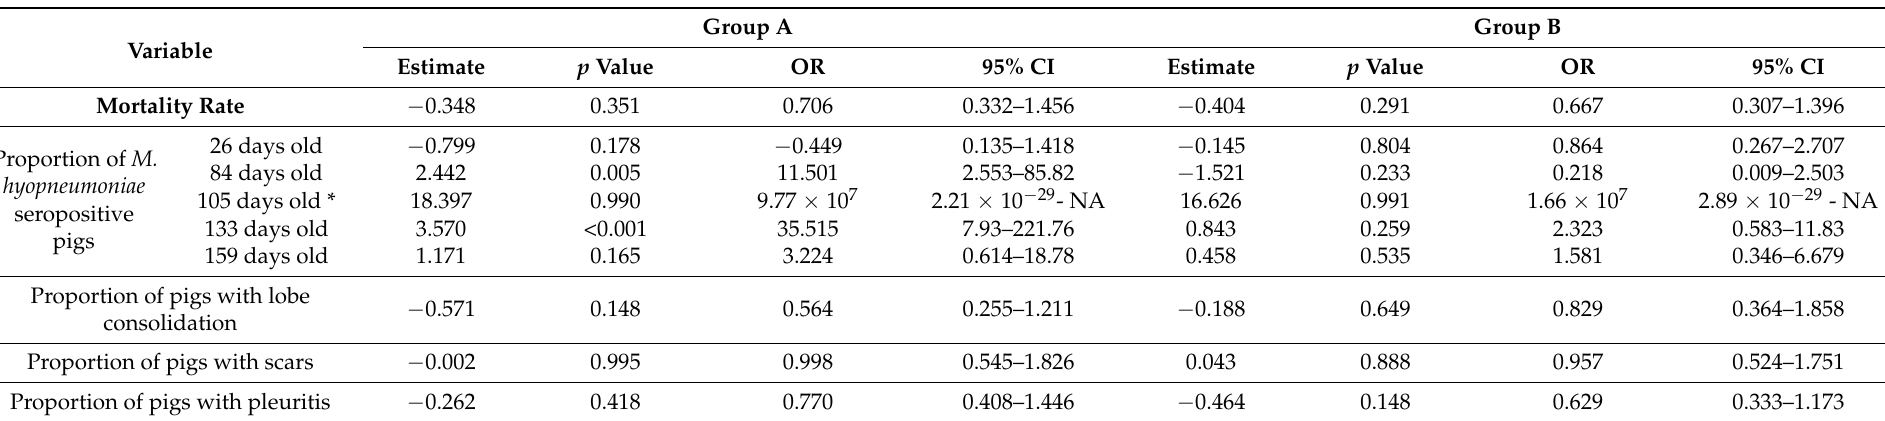
Table 2. Results of the logistic regression using the control group (Group C) as the